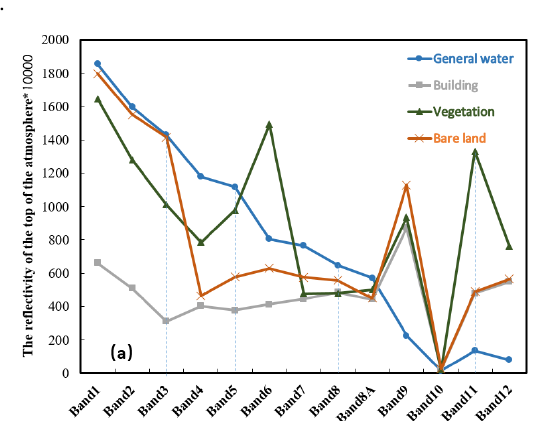
Figure 2. The spectral characteristics of different land